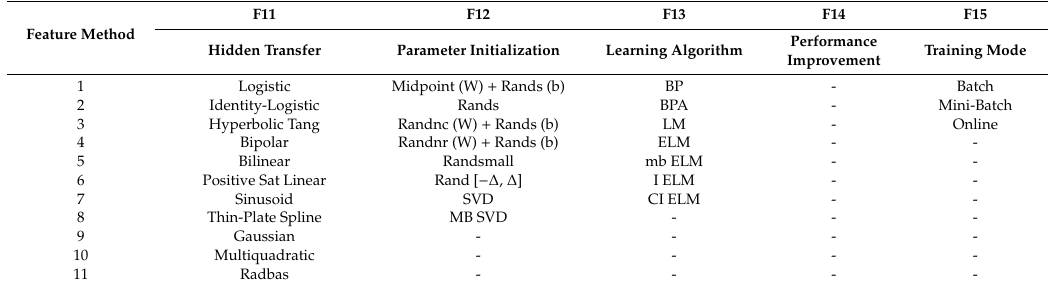
Table 5. ANN features 11 through